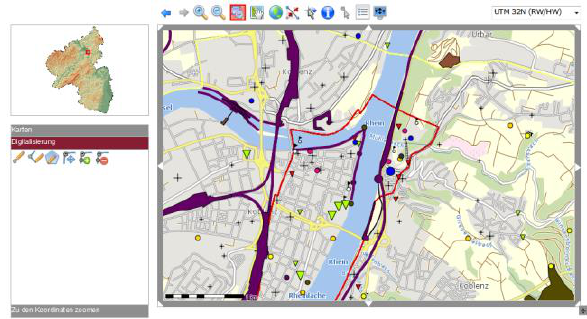
Figure 4. Web mapping application in KuLIS.